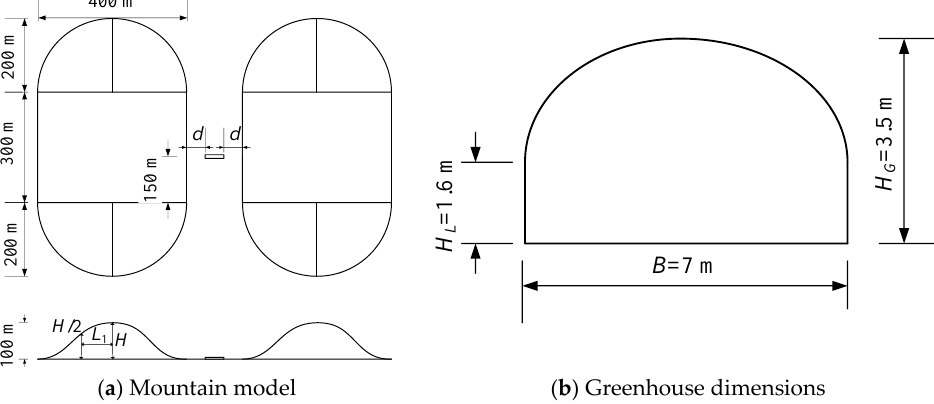
Figure 2. Size and layout of greenhouse and mountain.